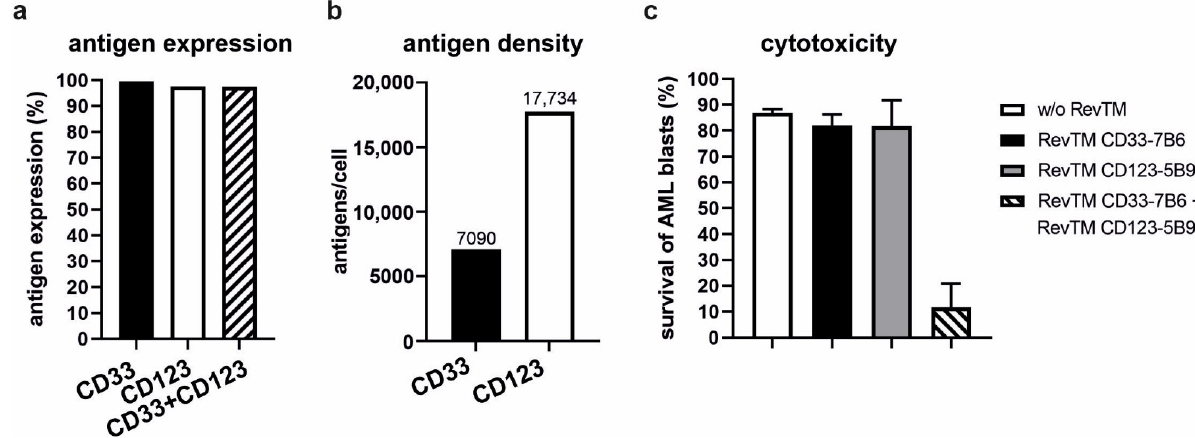
Figure 8. Combinatorial AND gate targeting of patient-derived AML blasts using the Dual-RevCAR system. ( a ) Expression of CD33, CD123 and CD33 + /CD123 + on patient-derived AML blasts was assessed by flow cytometry after staining with anti-CD33 and anti-CD123 commercial mAbs. ( b ) Number of tumor-associated antigens CD33 or CD123 on the surface of patient-derived AML blasts was determined using QiFi kit. ( c ) AND gate targeting was assessed on patient-derived AML blasts. Dual-RevCAR-E7B6-3z-E5B9-28 T-cells were co-cultured with the eFluor ™ 670-stained patient-derived AML blasts at a ratio of 1:1 in the presence of indicated RevTMs in a flow cytometry-based assay. The SIG RevCAR-E7B6-3z and the COS RevCAR-E5B9-28 receptors on Dual-RevCAR-E7B6-3z-E5B9-28 T-cells were triggered via the RevTM CD33-7B6 and RevTM CD123-5B9, respectively. Data for one sample of patient-derived AML blasts as mean ± SD is shown.